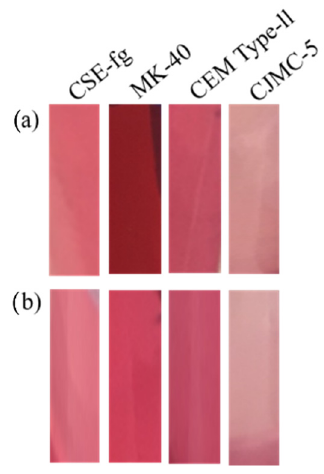
Figure 10. Photos of desorption solutions after the treatment of ( a ) entire coupons and ( b ) ground (cryogenic grinding) coupons.